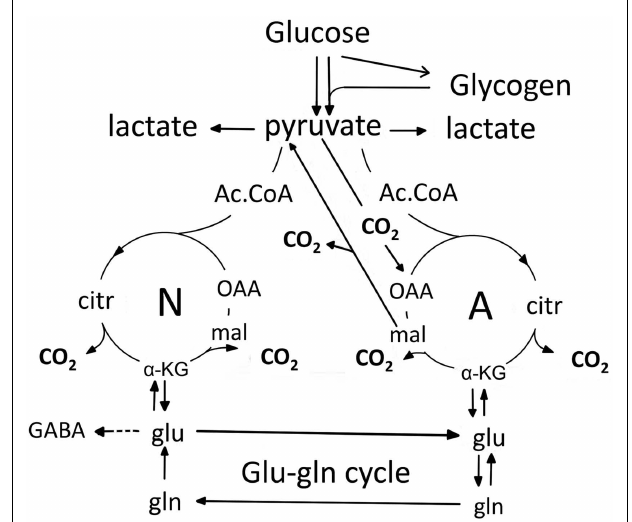
FIGURE 1 | Cartoon of glucose metabolism via pyruvate in neurons (left – N) and astrocytes (right –A) and of glutamine–glutamate (GABA) cycling . In both cell types pyruvate metabolism via acetyl Coenzyme A (ac.CoA) leads to formation of citrate by condensation with pre-existing oxaloacetate (OAA) in the tricarboxylic acid (TCA), an end-result of the previous turn of the cycle. Citrate oxidation in theTCA cycle includes two decarboxylations, leading to re-formation of oxaloacetate, ready for another turn of the cycle, and to production of large amounts of energy (ATP). Pyruvate carboxylation creates a new molecule of oxaloacetate, which after condensation with acetyl Coenzyme A, derived from a second molecule of pyruvate, forms a new molecule of citrate.This process can be used for replacement of wornTCA cycle intermediates. More important in the present context is that α -ketoglutarate ( α -KG), one of the intermediates of theTCA cycle can leave the cycle to form glutamate (glu) and, catalyzed by the cytosolic and astrocyte-specific enzyme glutamine synthetase, glutamine (gln). After release from astrocytes glutamine is accumulated in glutamatergic and GABAergic neurons [lower line ( V gln in the 13 C-NMR studies) of the glutamine–glutamate (GABA) cycle (glu–gln cycle), converted to glutamate (and in GABAergic cells onward to GABA)] and released as transmitter. Released glutamate is almost quantitatively re-accumulated in astrocytes, together with part of the released GABA [upper line ( V cyc in the 13 C-NMR studies) of the glutamine–glutamate (GABA) cycle (glu–gln cycle)] and re-accumulated in the astrocytic cytosol. Here, about 85% is converted to glutamine and re-enters the glutamine–glutamate (GABA) cycle.The remaining 15% is oxidatively degraded after re-conversion via α -ketoglutarate to malate, exit of malate to the cytosol, decarboxylation to pyruvate by the already mentioned cytosolic malic enzyme and further pyruvate oxidation in theTCA cycle via acetyl Coenzyme A. Combined astrocytic formation and oxidation of glutamate creates almost as much ATP as direct oxidation of glutamate (Hertz et al., 2007).